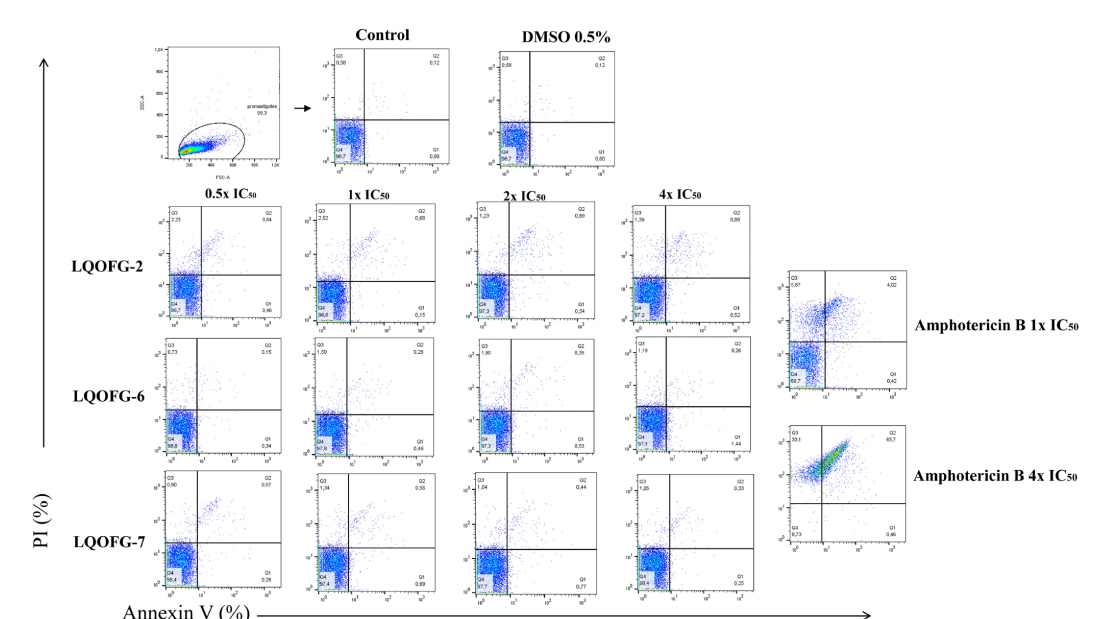
Figure 4. Analysis strategy of the representative dot plots showing staining of L. infantum promastig- otes. L. infantum promastigotes were incubated at 26 ◦ C for 24 h in the absence or presence of the LQOFG-2, LQOFG-6, LQOFG-7, or AmB at concentrations of 0.5 × , 1 × , 2 × , or 4 × the IC 50 . Annexin V/ PI (propidium iodide) staining was performed, and the samples were analyzed by flow cytometry.